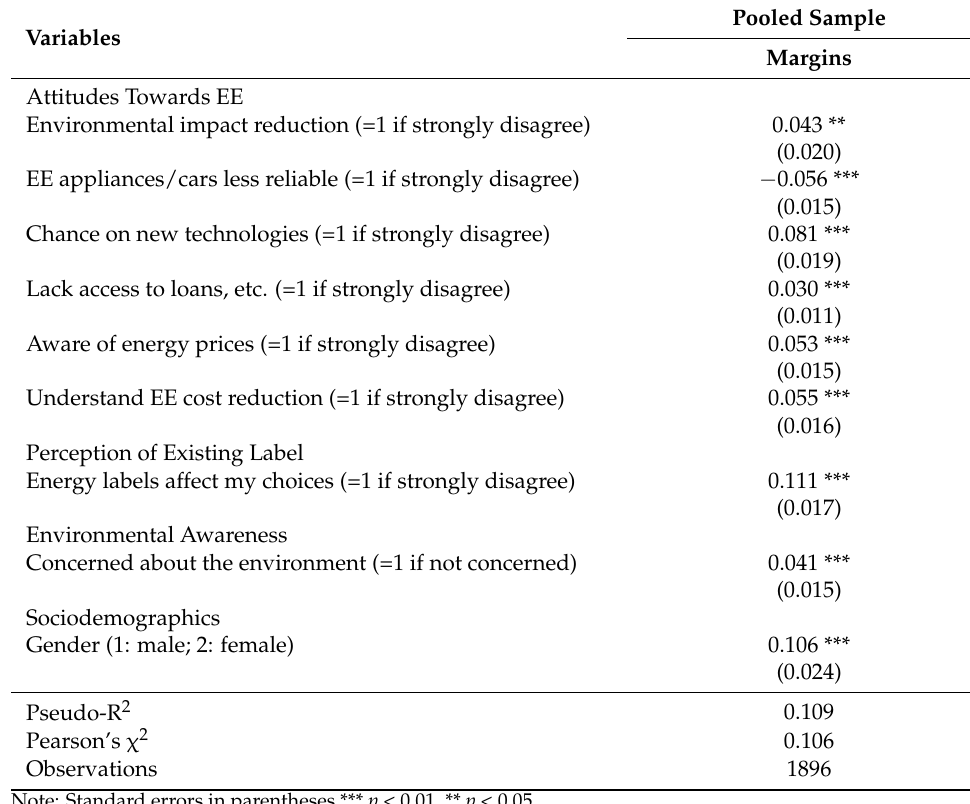
Table 1. Variables affecting households’ perceptions of energy efficiency—probit marginal effects (pooled